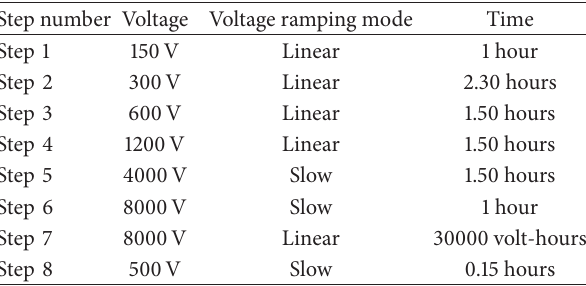
Table 1: IEF conditions for 11cm IPG